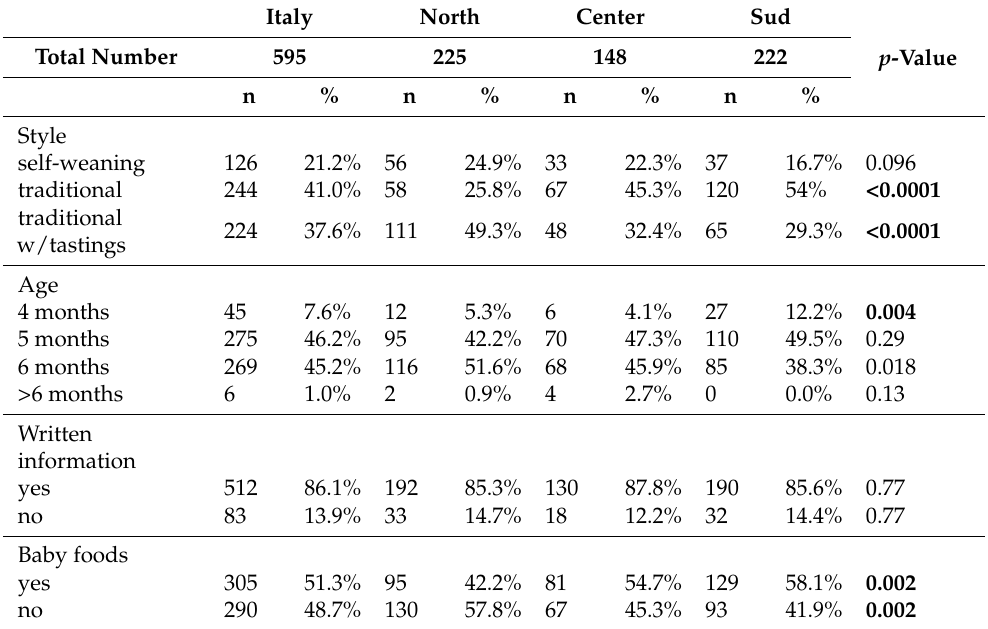
Responses from the PCP who fulfilled the questionnaire during the